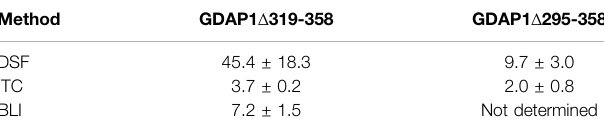
TABLE 2 | Binding af fi nities (K d , µM) of HA to GDAP1 using different